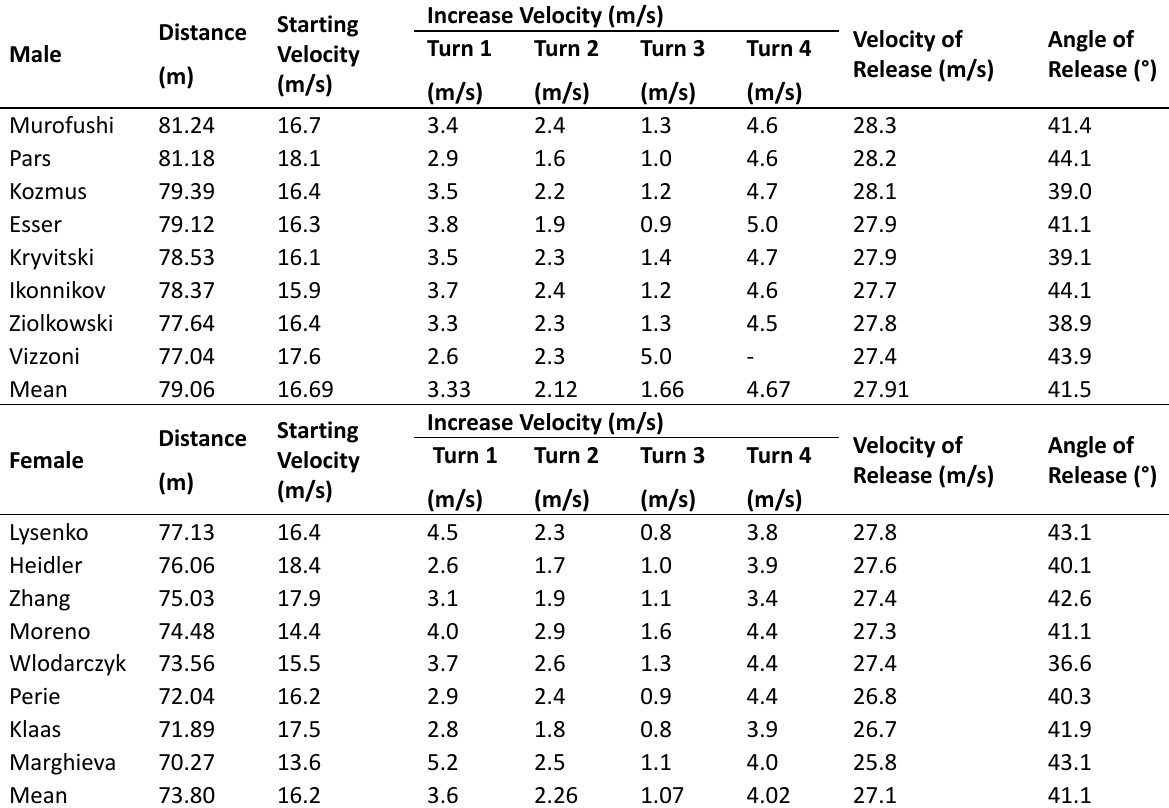
Table 1. The Kinematic Parameters of Male and Female Finalists WCh, Daegu 2011. [37]